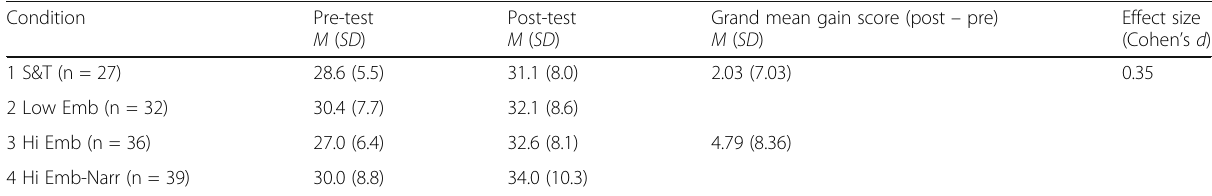
Table 4 Descriptives for post-test content knowledge with Wacom